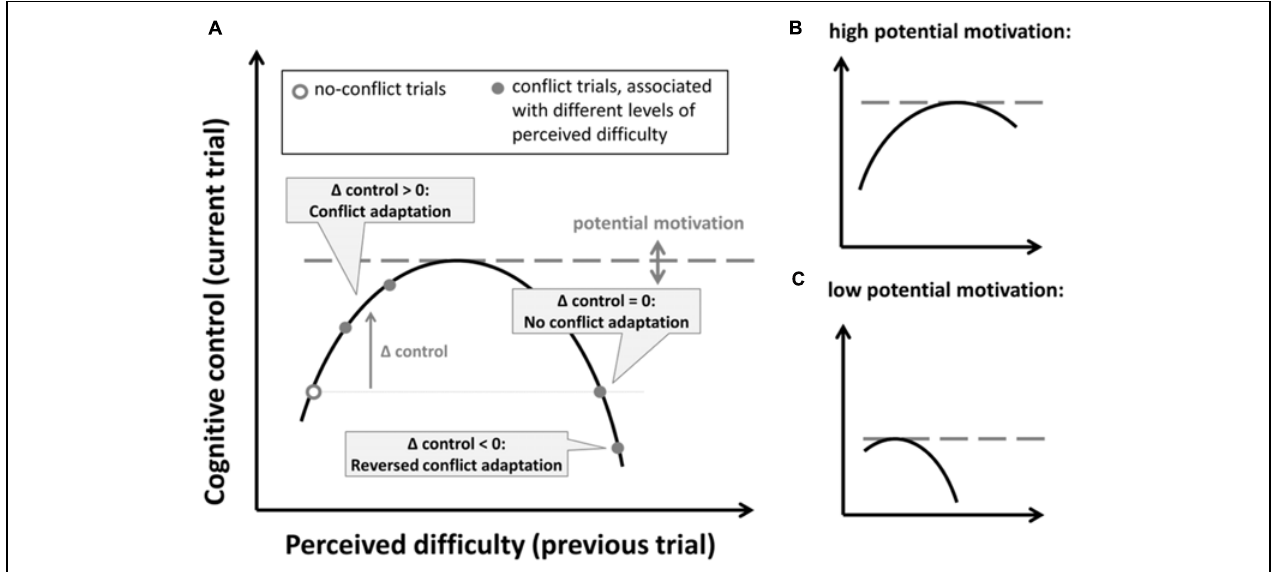
FIGURE 5 | (A) Hypothesized inverted U-shape relationship between perceived difficulty and subsequent increases in cognitive control. The level of potential motivation determines the upper limit of the curve. (B,C) Illustration of this relationship for a high (B) and low (C) level of potential motivation.